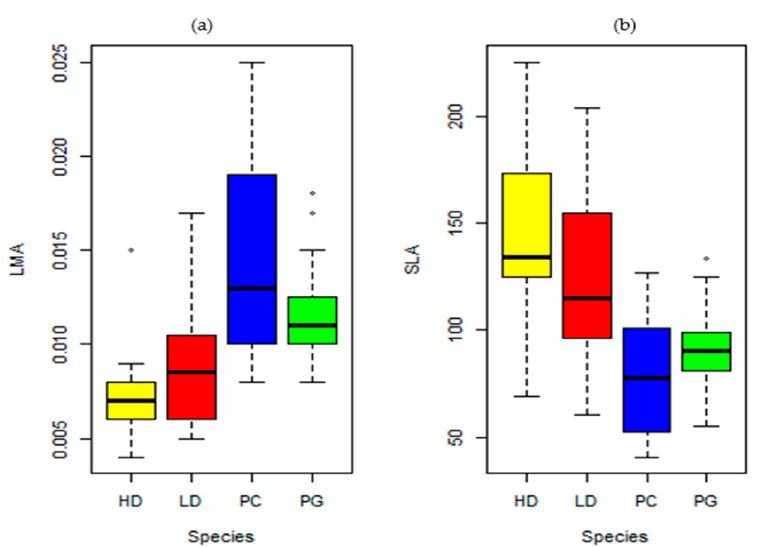
Figure 4. Boxplot of leaf-level functional traits. Vegetation structure: ( a ) LMA (g cm − 2 ) = leaf mass per area; ( b ) SLA (cm 2 g − 1 ) = specific leaf area; where the species are HD (yellow) = Hovenia dulcis ; LD (red) = Luehea divaricata ; PC (blue) = Psidium cattleianum ; PG (green) = Psidium guajava . * Indicates outliers.